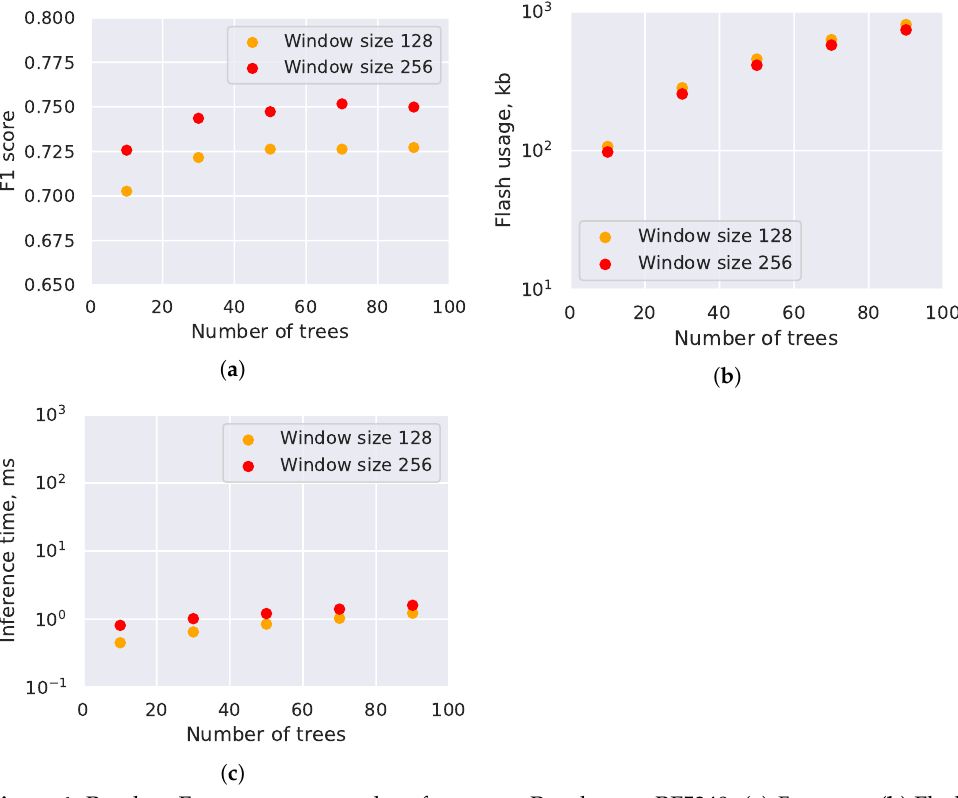
Figure 4. Random Forest accuracy and performance. Results on nRF5340. ( a ) F 1 scores. ( b ) Flash memory usage. ( c ) Inference time, including feature extraction